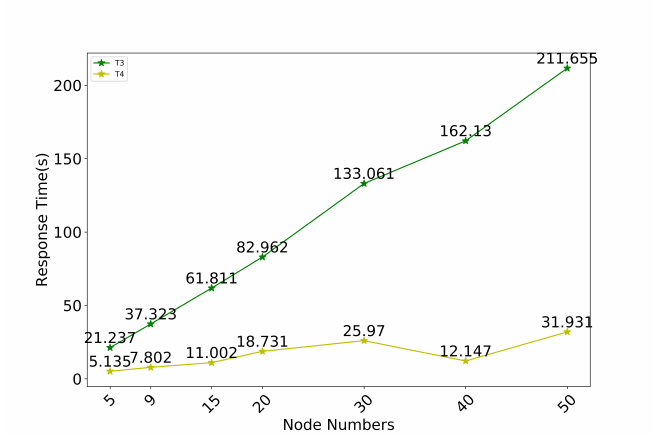
Figure 9. Evaluation results of the impact of nodes number on system